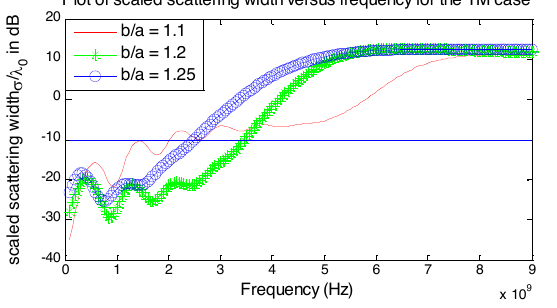
FIGURE 7. Normalized backscattering width (TM polarization) versus frequency of Rings only media coating for b/a = 1.1, 1.2 and 1.25 with fixed c/a = 1.3